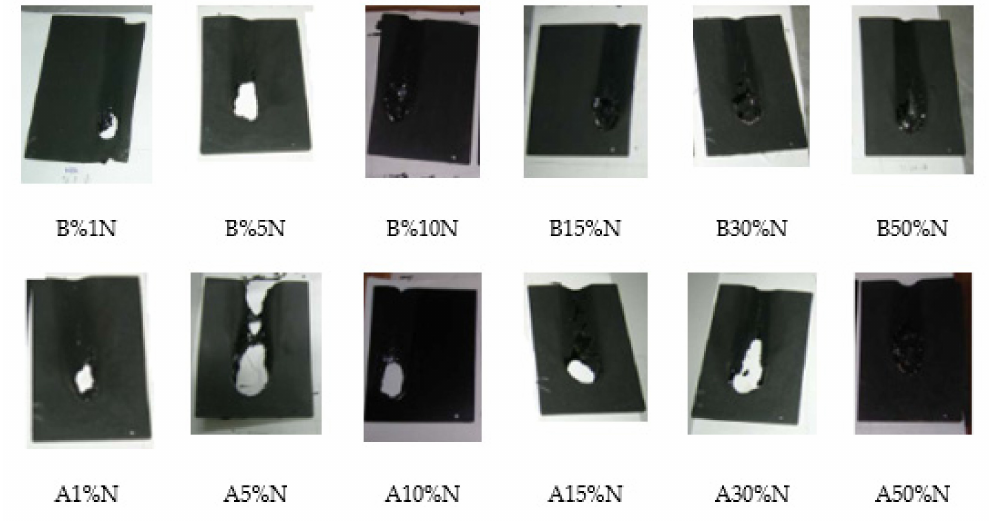
Figure 8. Candle flame test results of the composite